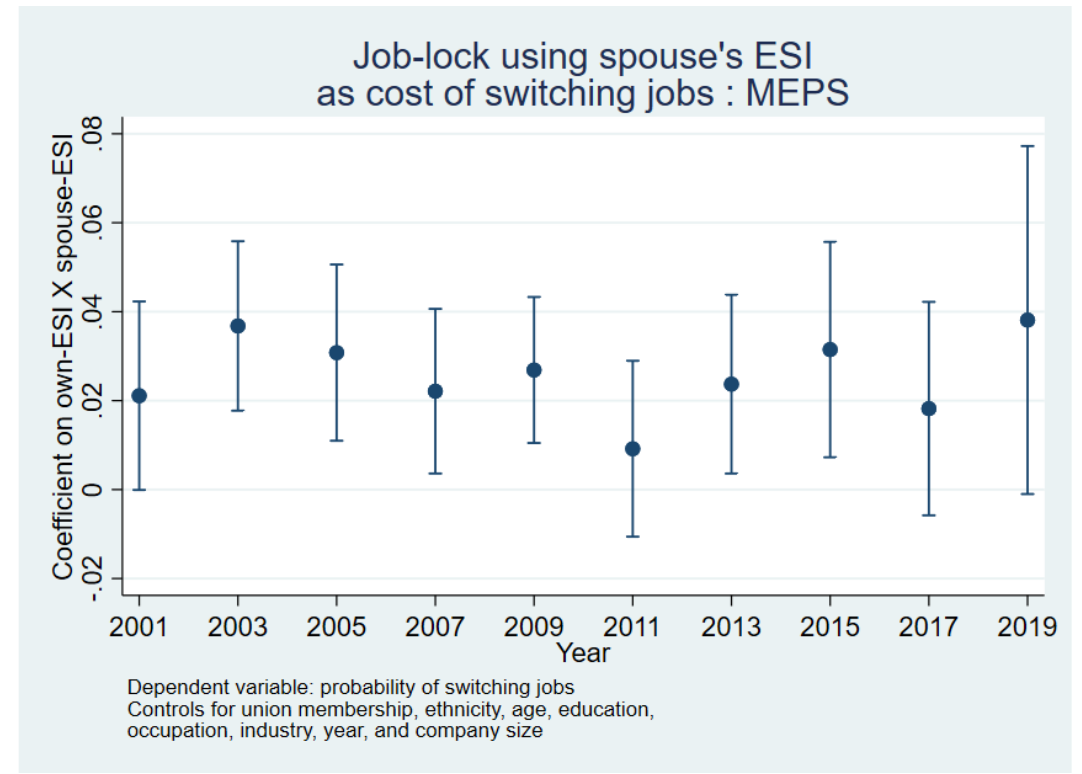
Figure 3. Period-Specific DD Estimates of Job Lock from the MEPS.